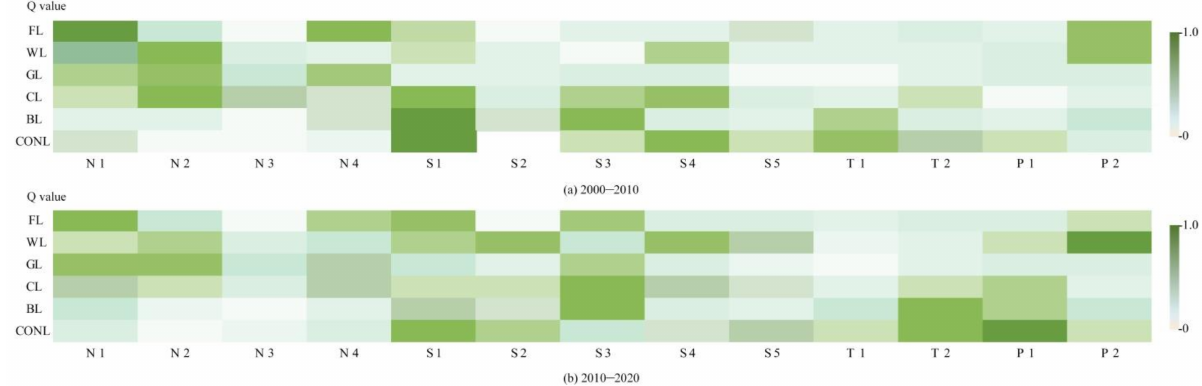
Figure 5. Influencing factors of land use changes: ( a ) From 2000 to 2010 and ( b ) from 2010 to